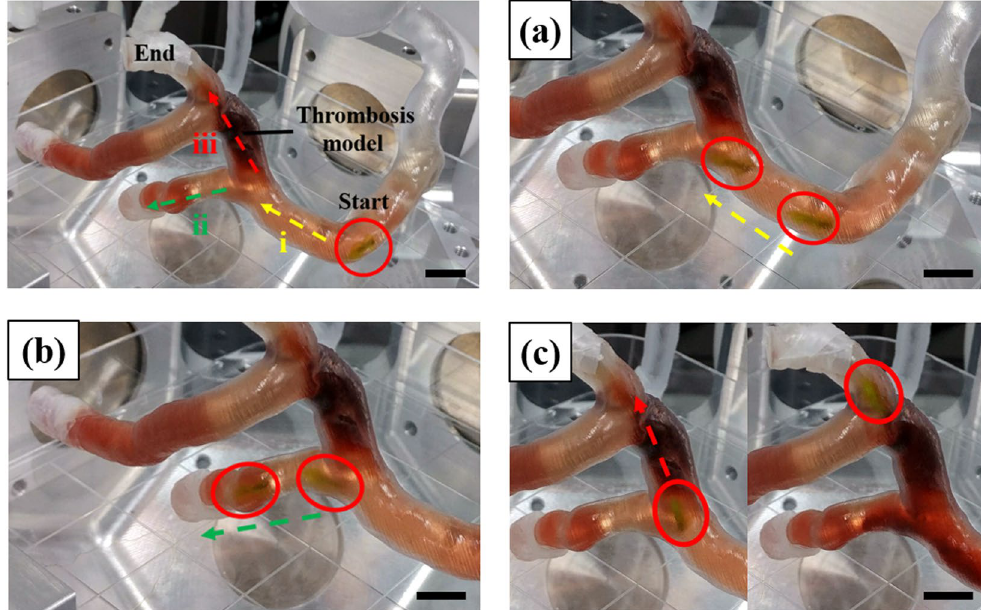
Figure 5. Magnetic manipulation and drilling performance in the 3D phantom. Magnetic manipulation and drilling performance of the MDA in the 3D phantom of coronary artery of the heart: ( a ) movement to a branch of the blood vessel, ( b ) selective movement through the lower blood vessel, and ( c ) selective movement to the blood vessel blocked by an artificial thrombosis model and perforation of it. Scale bar represents 10